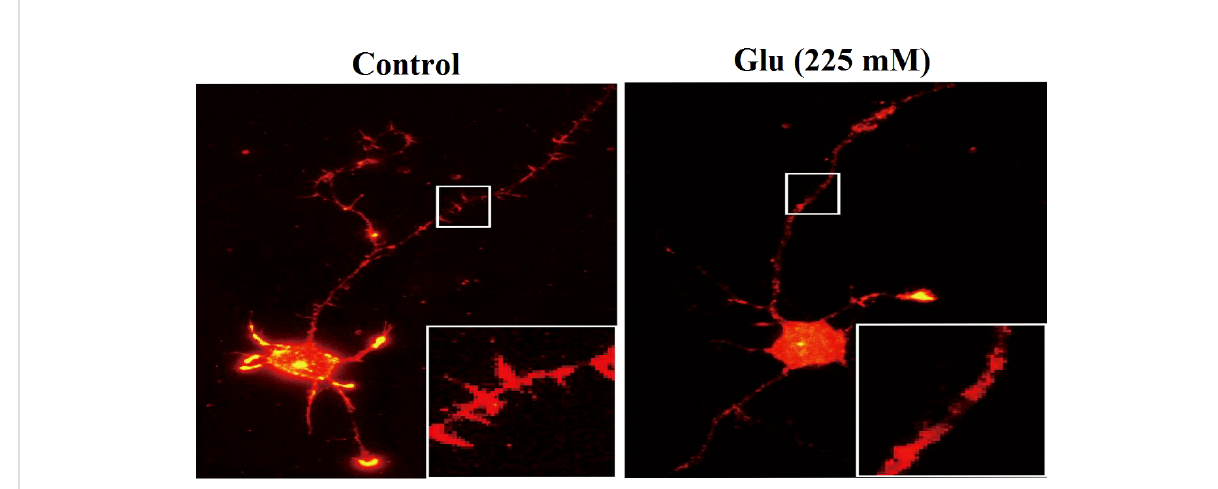
FIGURE 6 Immuno fl uorescence analysis of the changes of dendritic spines of neurons under high glucose stimulation